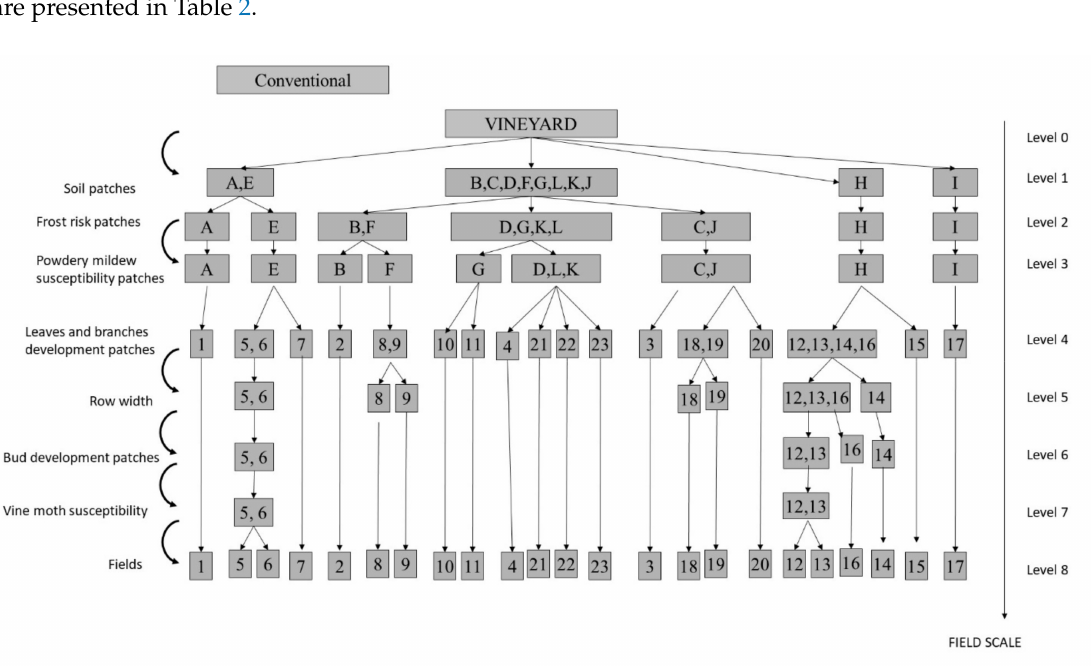
Figure 3. Patch hierarchy established for the studied vineyard (Step 3). Each level was associated with a characteristic of the fields or geographical group of fields. (Figure 3a). The patches at a given level were created by breaking down the patches at the upper level according to the characteristics given on the left side of the figure. The letters represent the geographical groups of fields (see Figure 2) and the field numbers (see Figure 2). Each patch is composed of a technical subsystem and a biophysical